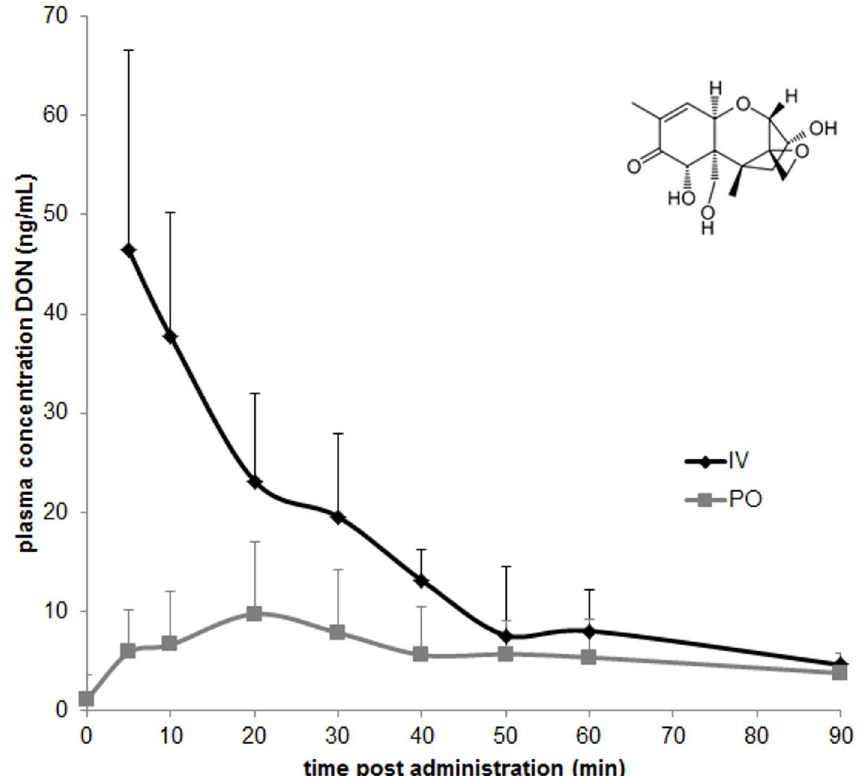
Fig 1. Chemical structure (insert) and plasma concentration-time profile of deoxynivalenol (DON) after single IV (n = 10) and PO (n = 10) administration of 0.3 mg DON/kg bodyweight to racing pigeons. Valuesare presented as means +